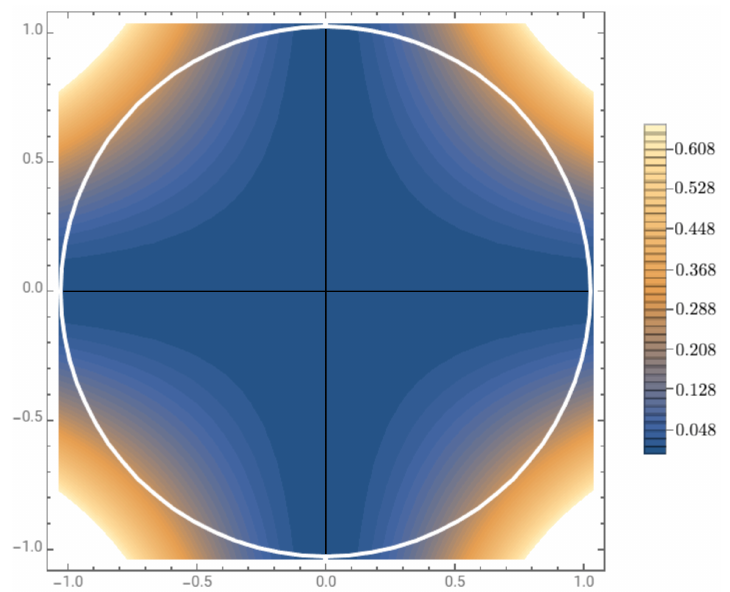
Figure 5. The polar graph of the lower bound r 4 bound is 0 only for points with coordinates ( r , ϑ ) lying on the opponency axes, identified with the horizontal and vertical axes in the picture. The lower bound is maximal for ( r , ϑ ) = ( 1, π k =